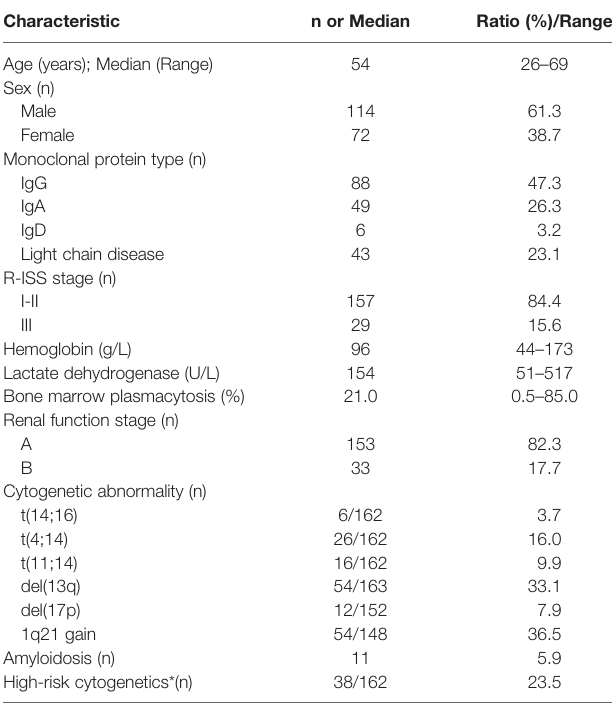
TABLE 1 | Baseline information of the 186 NDMM patients at disease